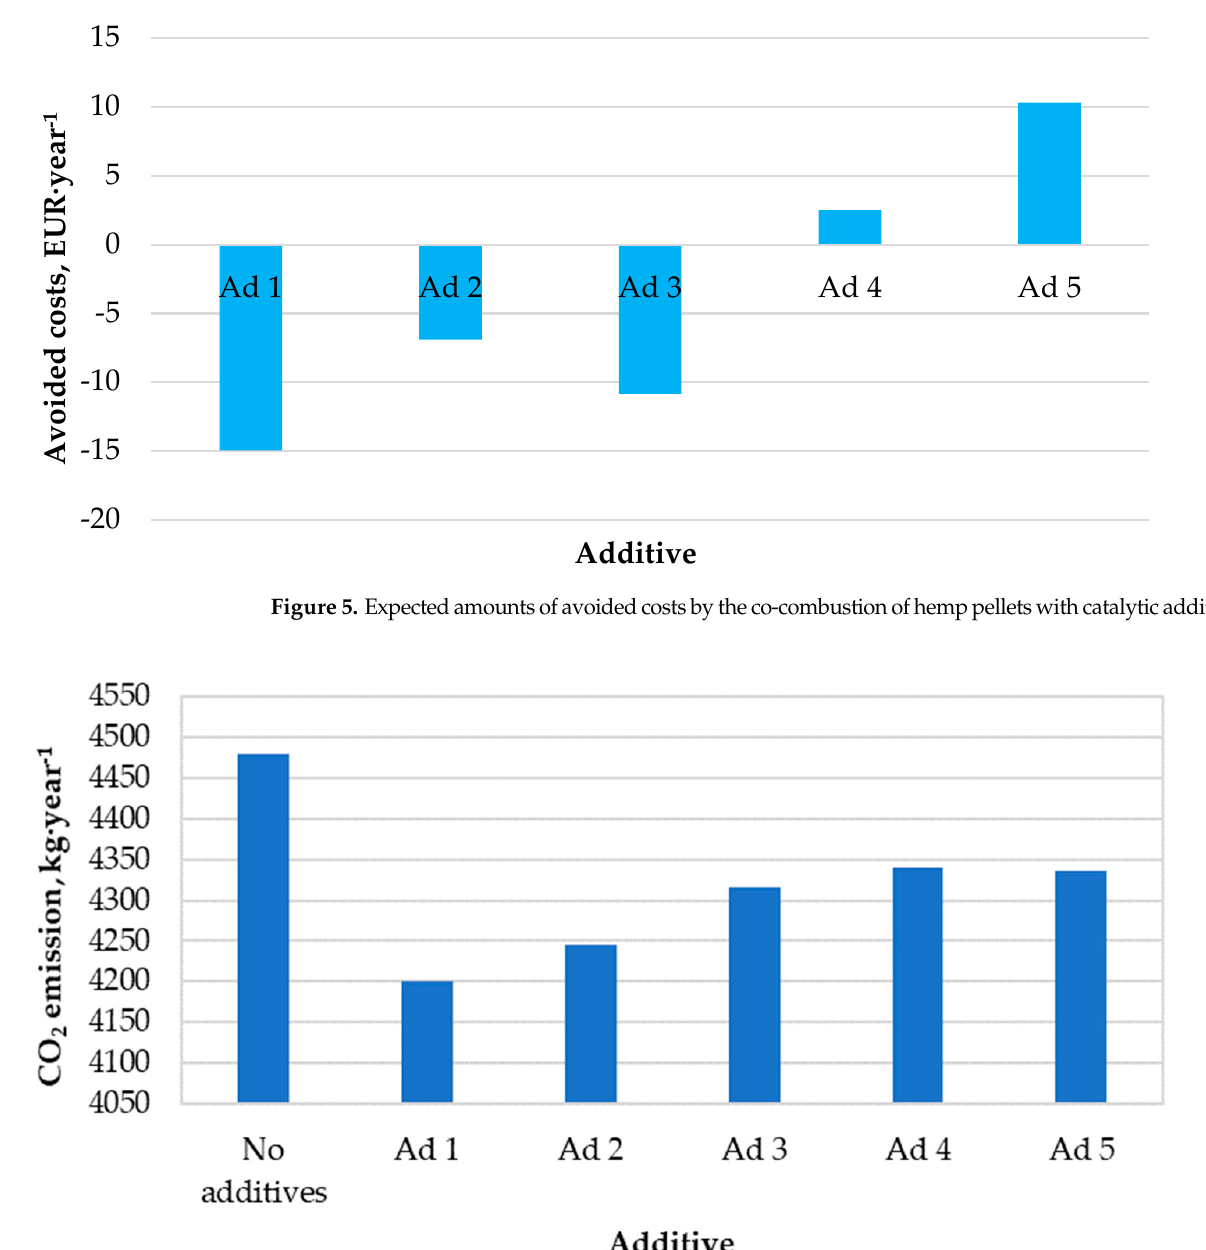
Figure 6. Annual amount of carbon dioxide emissions into the